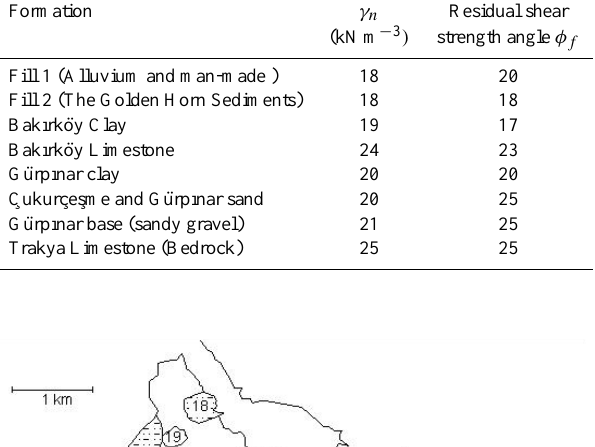
Table 4. Residual shear strength angles for major formations con- sidered in the seismic slope stability assessment (Yıldırım and Savas¸kan, 2002).